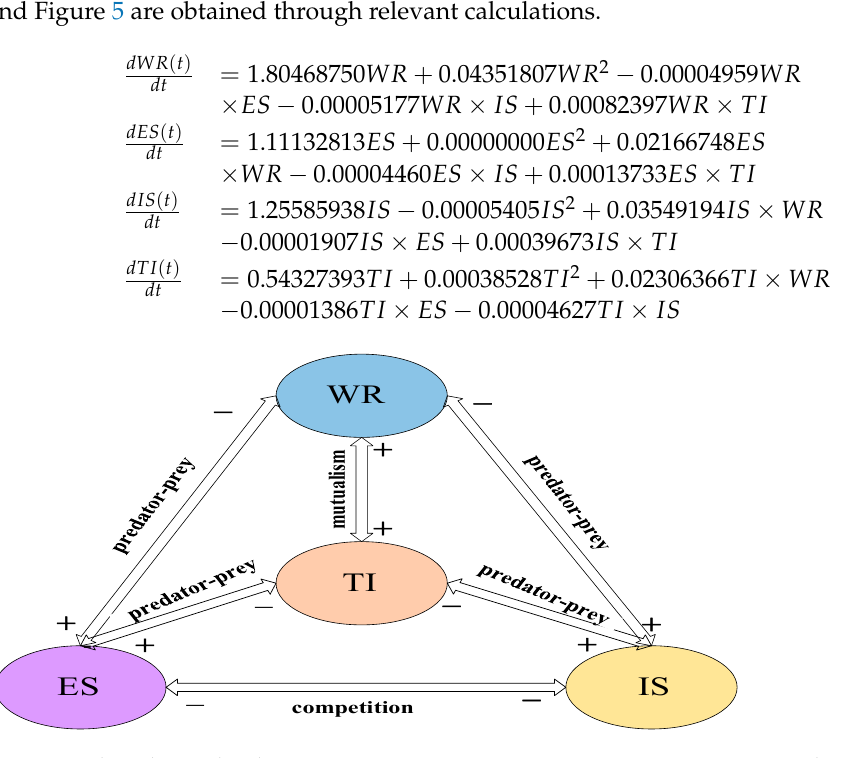
＋ ＋＋ － Figure 6. The relationship between Water Resources System-Economy System-Industrial System- Technology Innovation System in Hebei. 4.1.3. Equilibrium and Stability